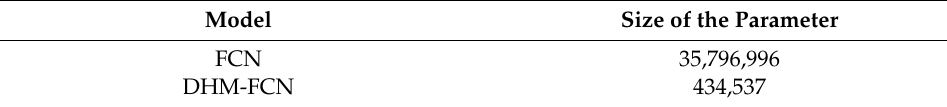
Table 1. Parameters of the traditional FCN model and the DHM-FCN model. Model Size of the Parameter